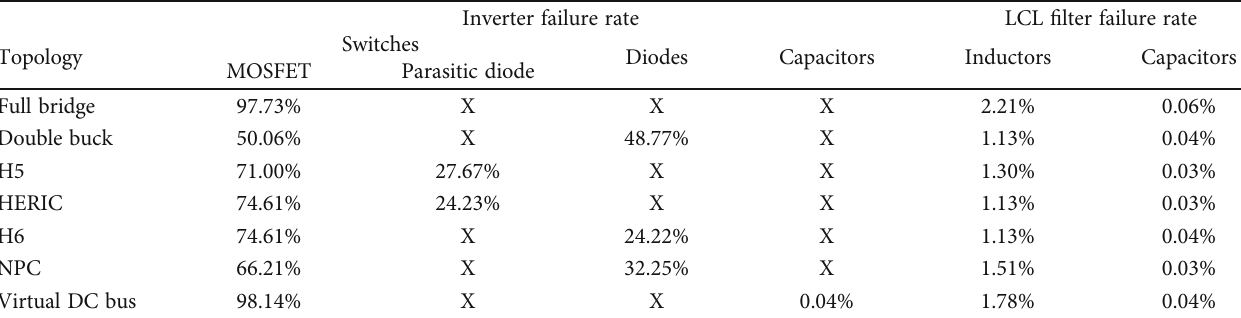
Table 13: Percentage of contribution to the failure rate of the photovoltaic